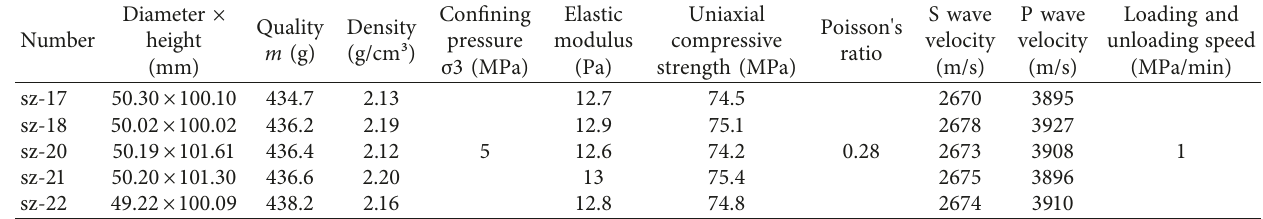
Table 1: Basic information of yellow sandstone.